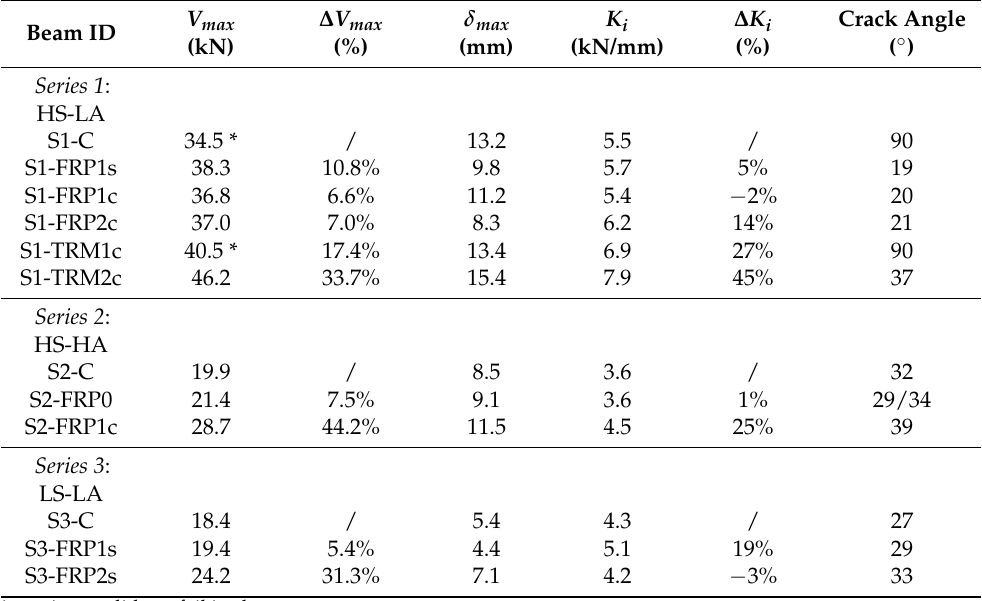
Table 5. Experimental results for all beam specimens.